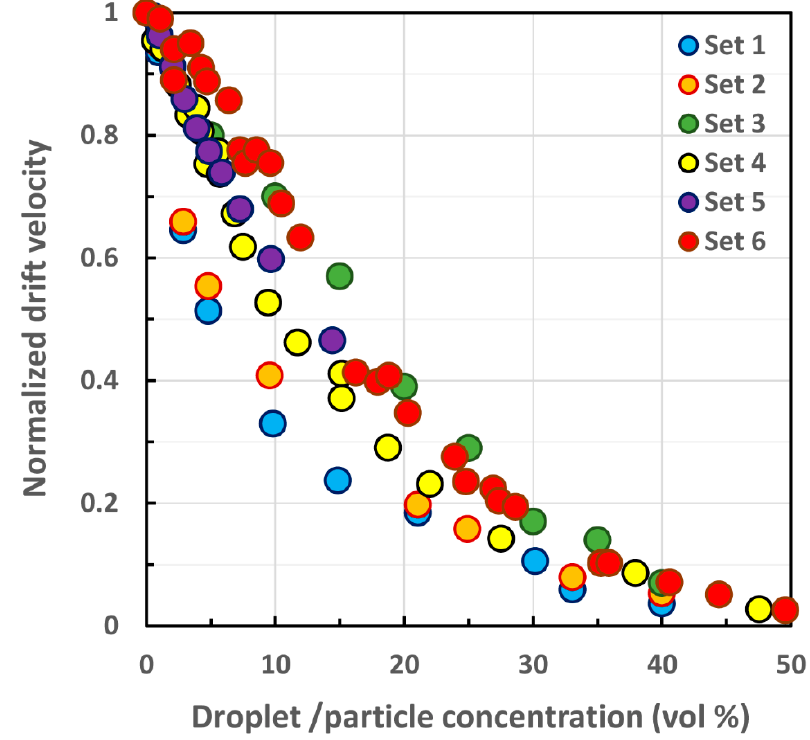
Figure 4. Experimental data for creaming/sedimentation of emulsions and suspensions plotted as normalized drift velocity versus droplet or particle concentration (vol. %).